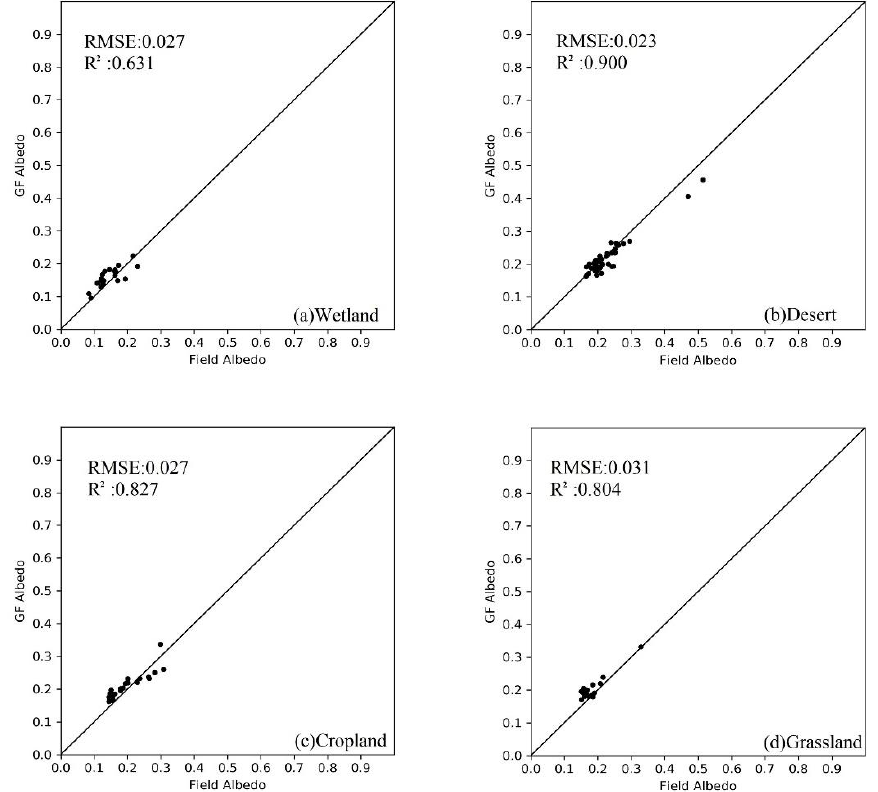
Figure 4. Comparison of the estimated albedo of GF-1 WFV with the ground measurements for different land cover types.